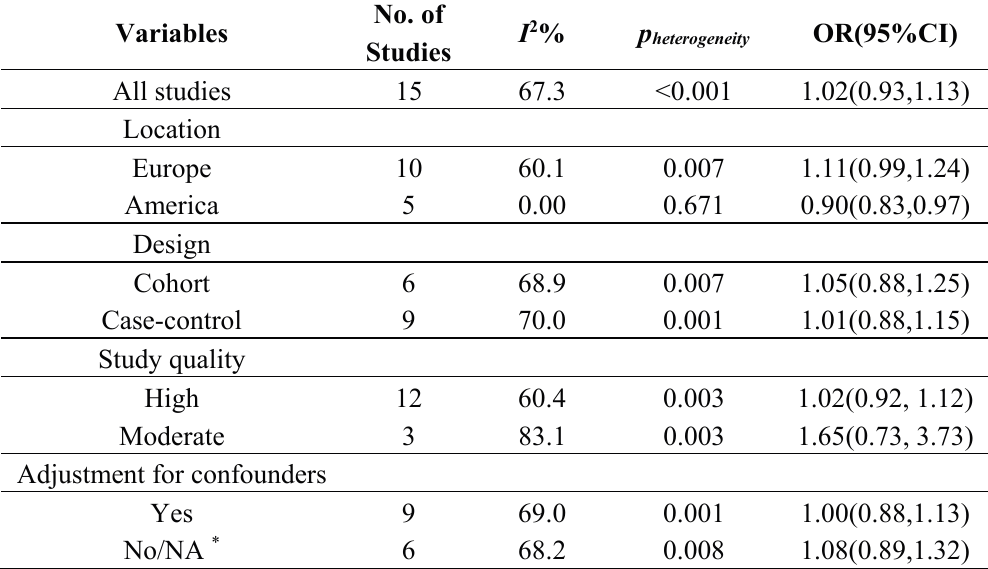
Table 2. Summary results of association between maternal smoking during pregnancy and ASD